Question: Draft a figure caption describing what is shown.
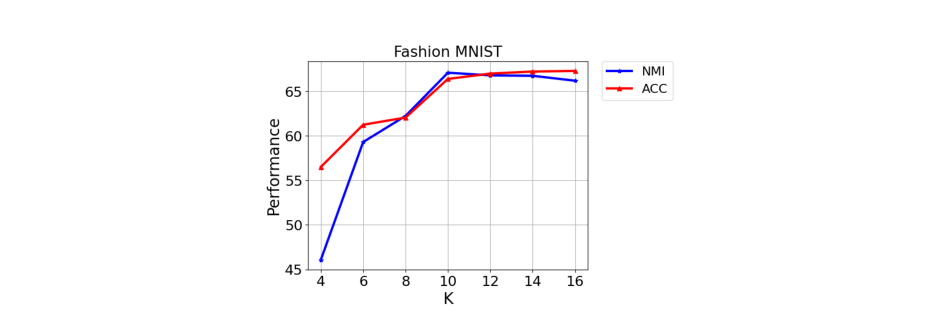
Answer: Sensitivity of DCSS model to the initial number of clusters (K).